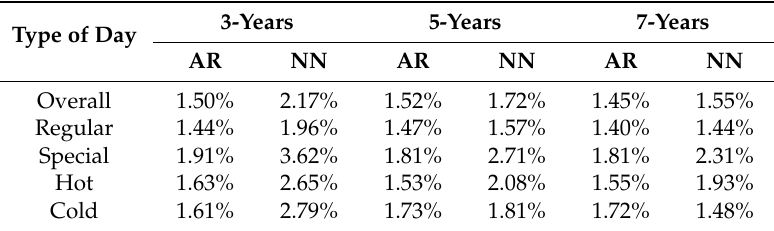
Table 2. Forecasting error (RMSE) with training periods from 3 to 7 years. Type of Day